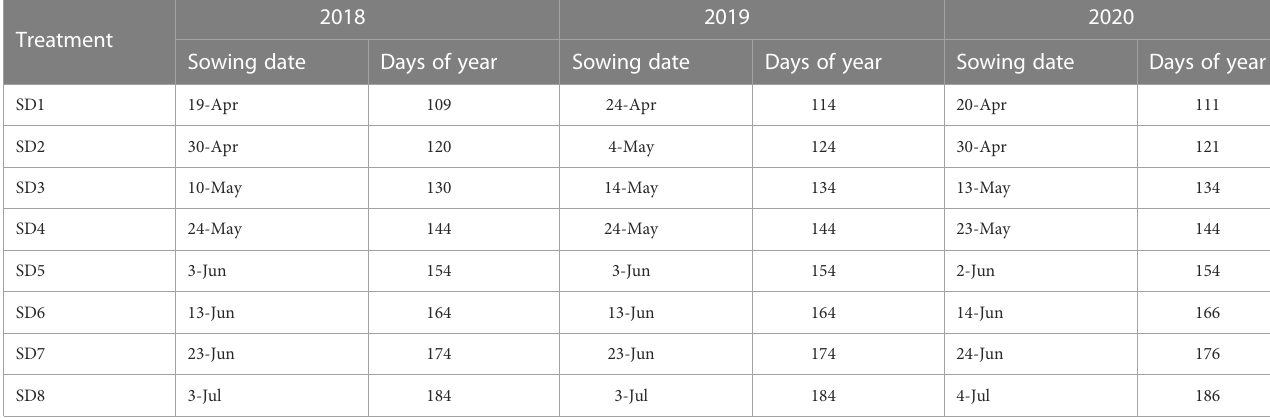
TABLE 2 The sowing dates for each treatment established each year from 2018 to 2020. Treatment